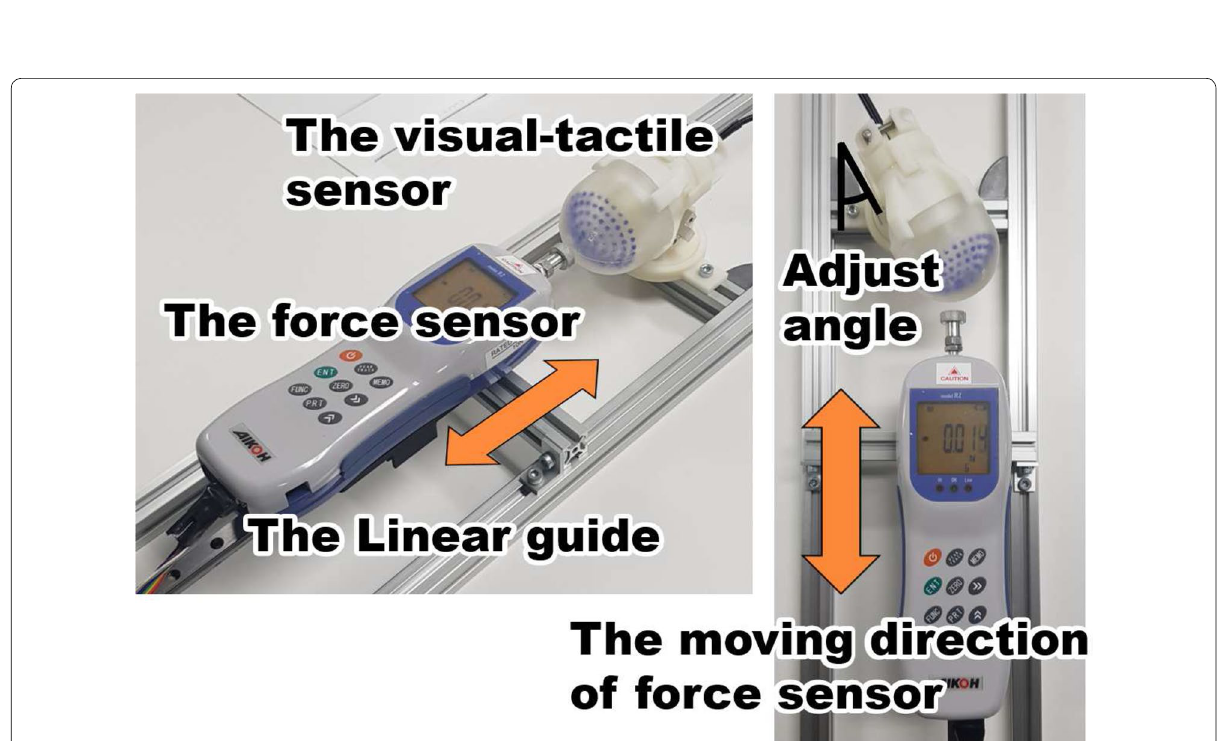
Fig. 9 Experiment device to check the contact position of visual tactile sensor